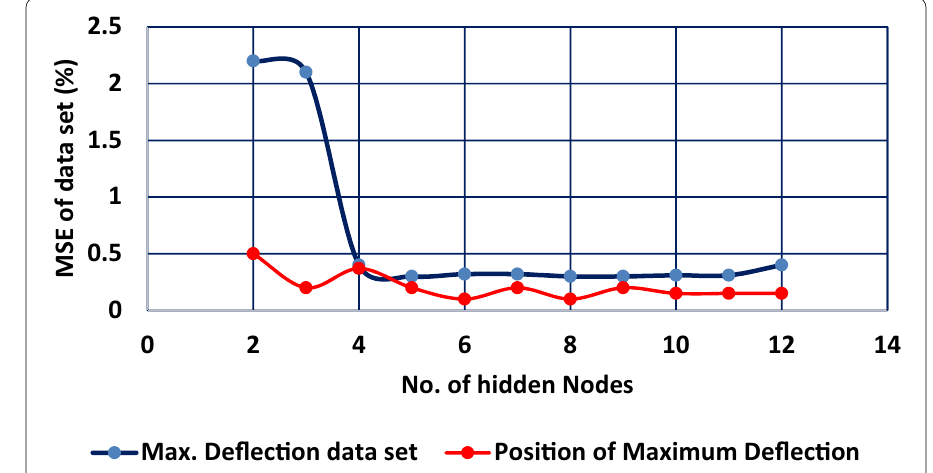
Fig. 4 Variation of Mean squared error with different hidden layer nodes